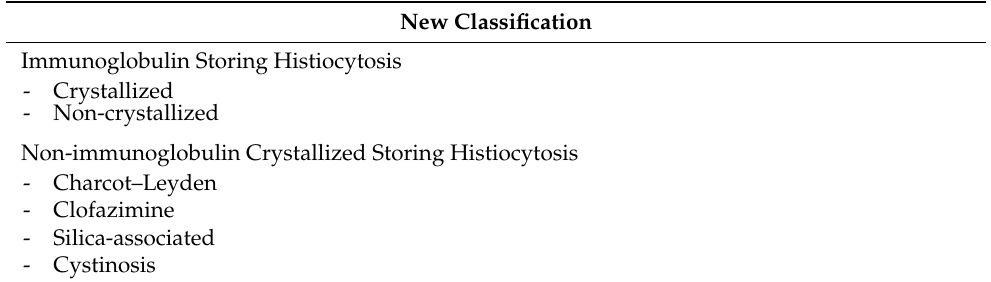
Table 5. Proposal of new